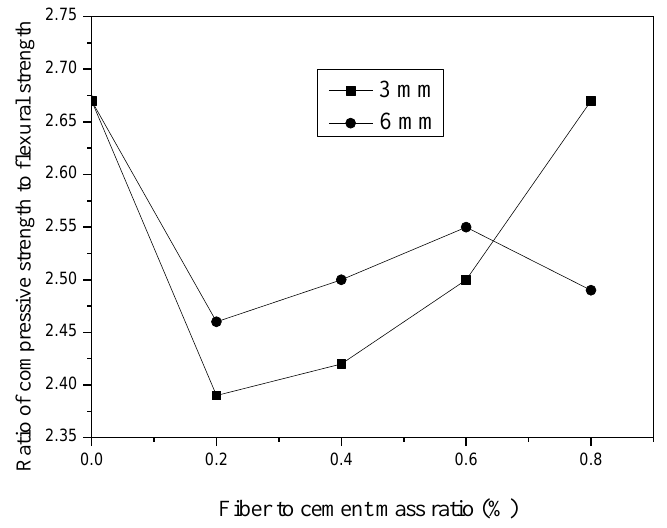
Fiber to cement mass ratio (%) Figure 13. Effect of fiber on the compressive strength-to-flexural strength ratio of mortars. Although the curve with the lowest slope in Figure 14b was the 0.2% fiber content, the difference among the slopes of the five curves was small. The comparison with Figure 14a shows that the influence of the 6-mm fiber on the elastic modulus of the mortar was